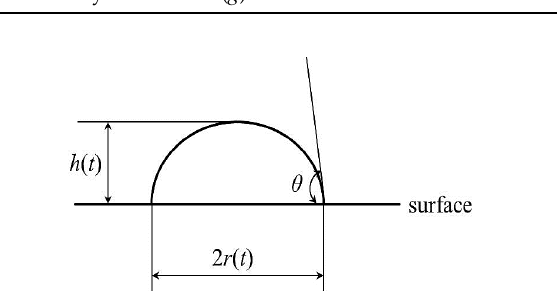
Figure 3. Sketch of a droplet of water ‐ based paint on the solid surface after impact.